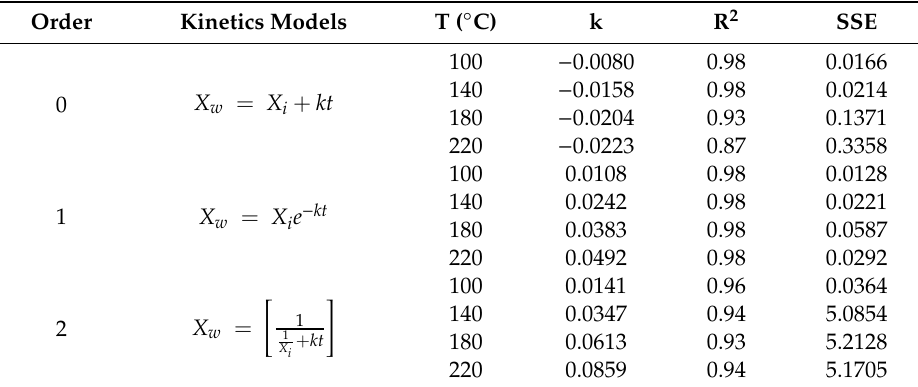
Table 2. Kinetic constants for model of n order and adjusted coe ffi